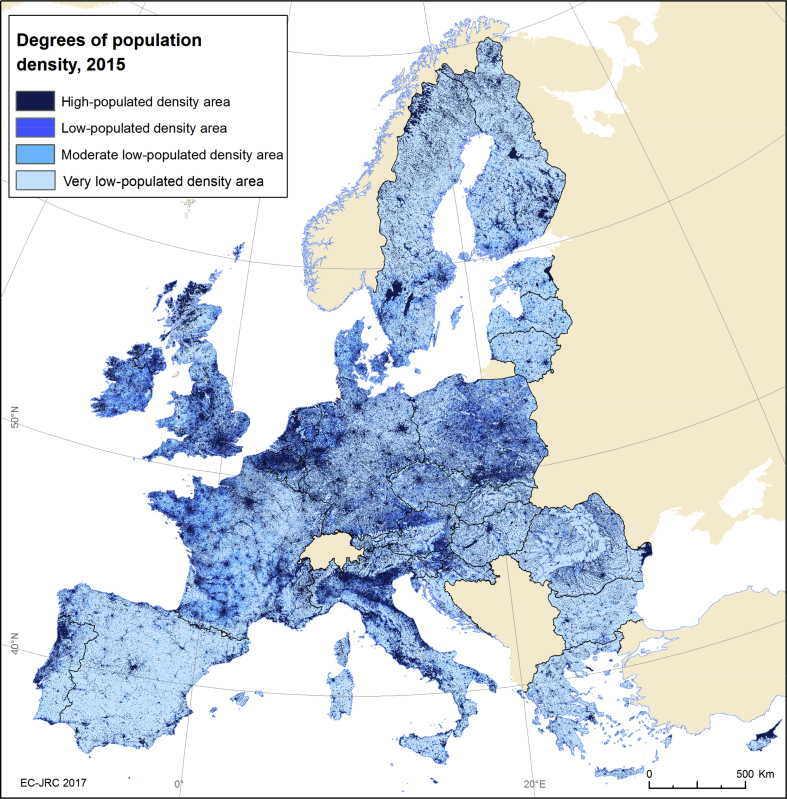
Map depicting (low) population density areas in the EU countries and the UK, 2015.